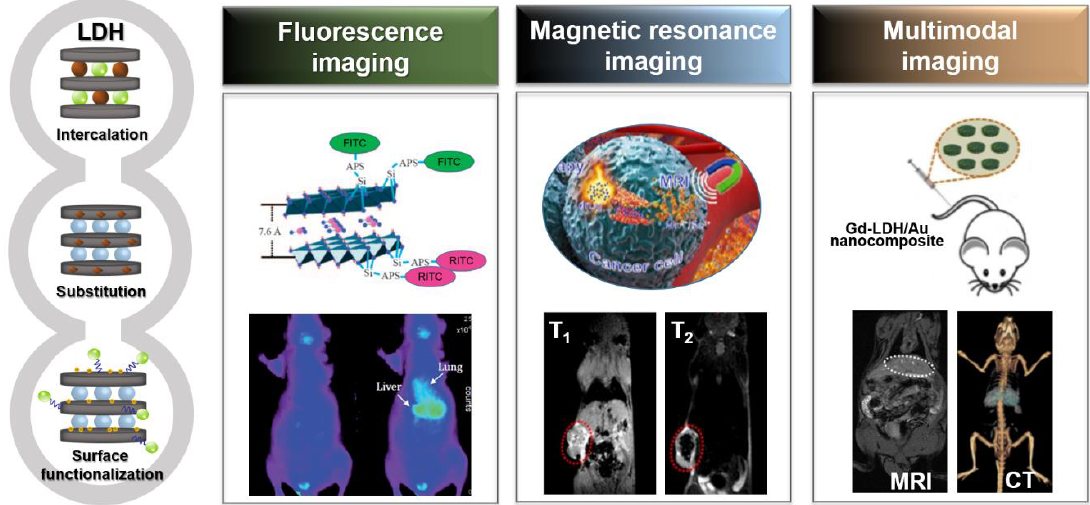
Figure 1. Overview of functional layered double hydroxide nanohybrids (left) and their related application systems (right): fluorescence imaging, reproduced from [20,35], with permission from the Royal Society of Chemistry, 2012 [20] and Wiley-VCH Verlag GmbH & Co. KGaA, 2009 [35], magnetic resonance imaging (MRI), reproduced from [11,12], with permission from the Royal Society of Chemistry, 2017 [11] and American Chemical Society, 2019 [12], and multimodal imaging, reproduced from [10], with permission from Elsevier Ltd., 2013.